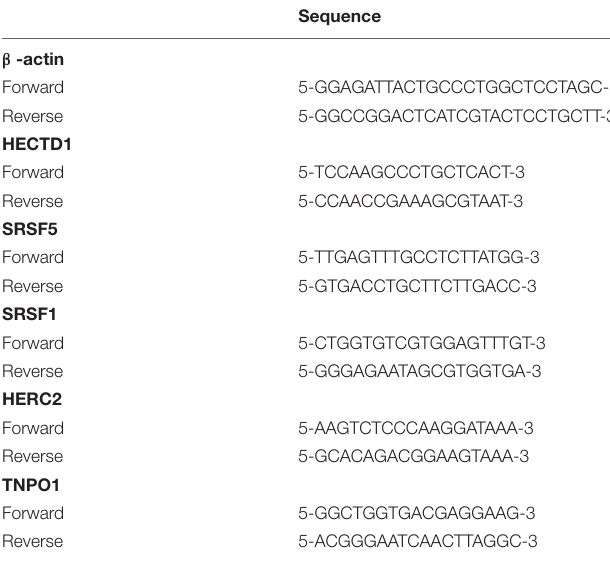
TABLE 1 | Primers used in quantitative real-time PCR